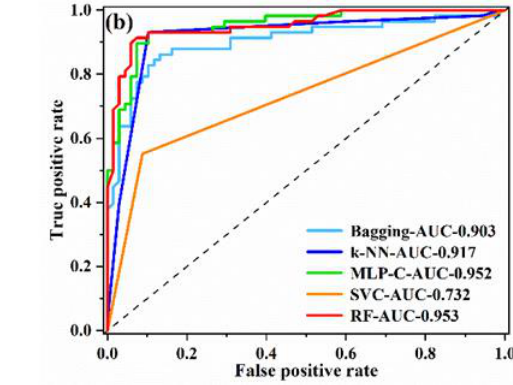
Figure 3. The performance of classification models on the training set: ( a ) accuracy and F1-score; ( b ) ROC curves.